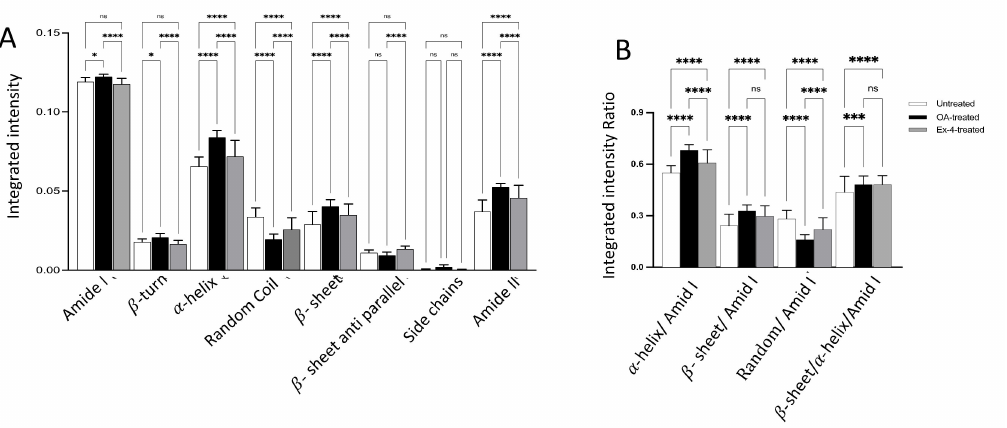
Figure 5. Comparison of several representative spectral parameters in the protein region between the untreated, steatotic, and Ex-4-treated HepG2 cells. ( A ) Relative proportion of the secondary structures of polypeptides in the protein region. ( B ) Integrated intensity ratios of the different secondary structures of polypeptides. All of the values are expressed as the mean ± SE. The FTIR spectra analyzed were 70, 80, and 80 for the untreated, steatotic, and Ex-4-treated HepG2 cells, respectively. Each treatment condition was repeated three times. The comparison between different treatments was performed using ANOVA followed by Turkey’s post hoc test. *, ***, and **** indicate p < 0.05, p < 0.001, and p < 0.0001, respectively. ns indicates